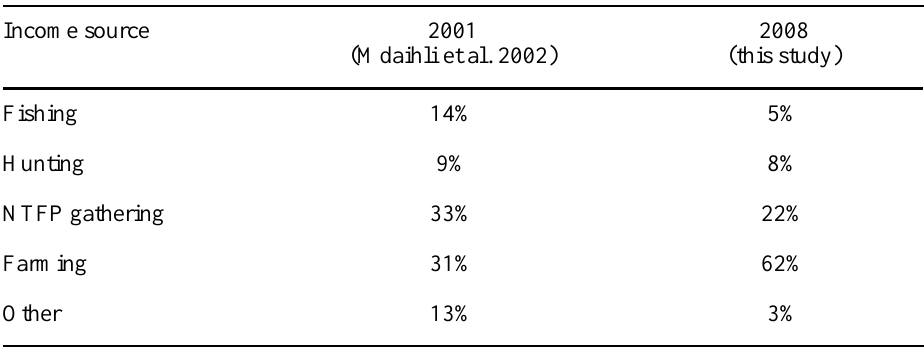
Table 3. Comparison of the importance of fishing, hunting, NTFP gathering, and farming, as declared by households in 2001 and 2008 (estimated as the percentage of households that declared an activity to be their main source of